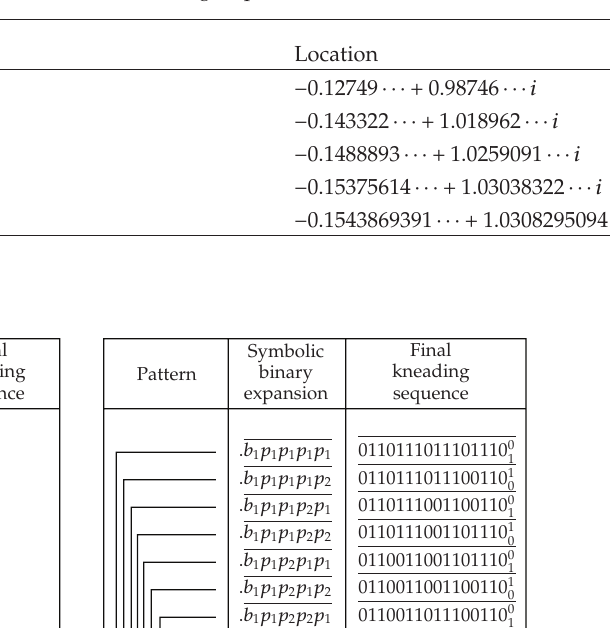
Table 2: Location of canonical single-spiral medallions.